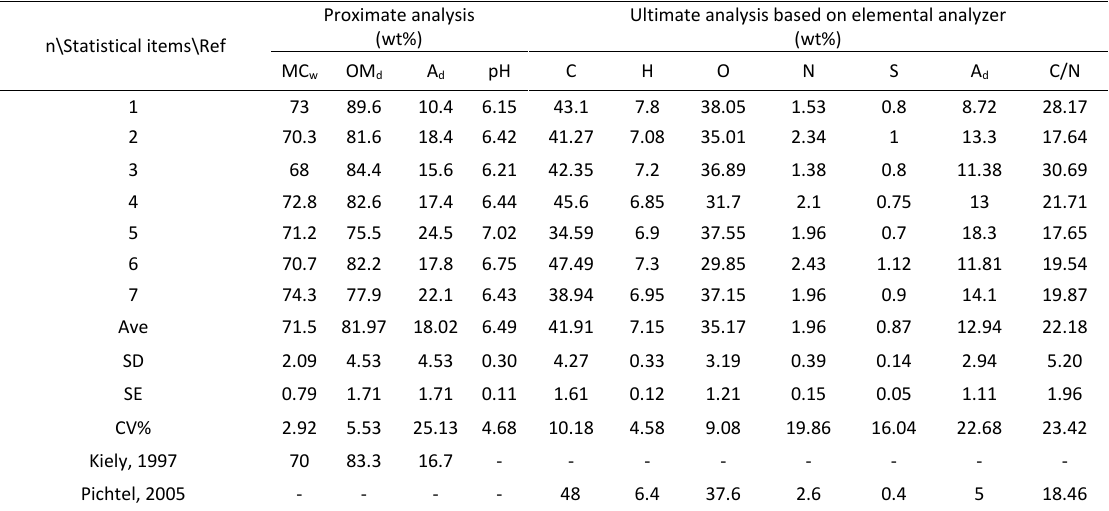
Table 3: Proximate and ultimate analyses of the food waste *